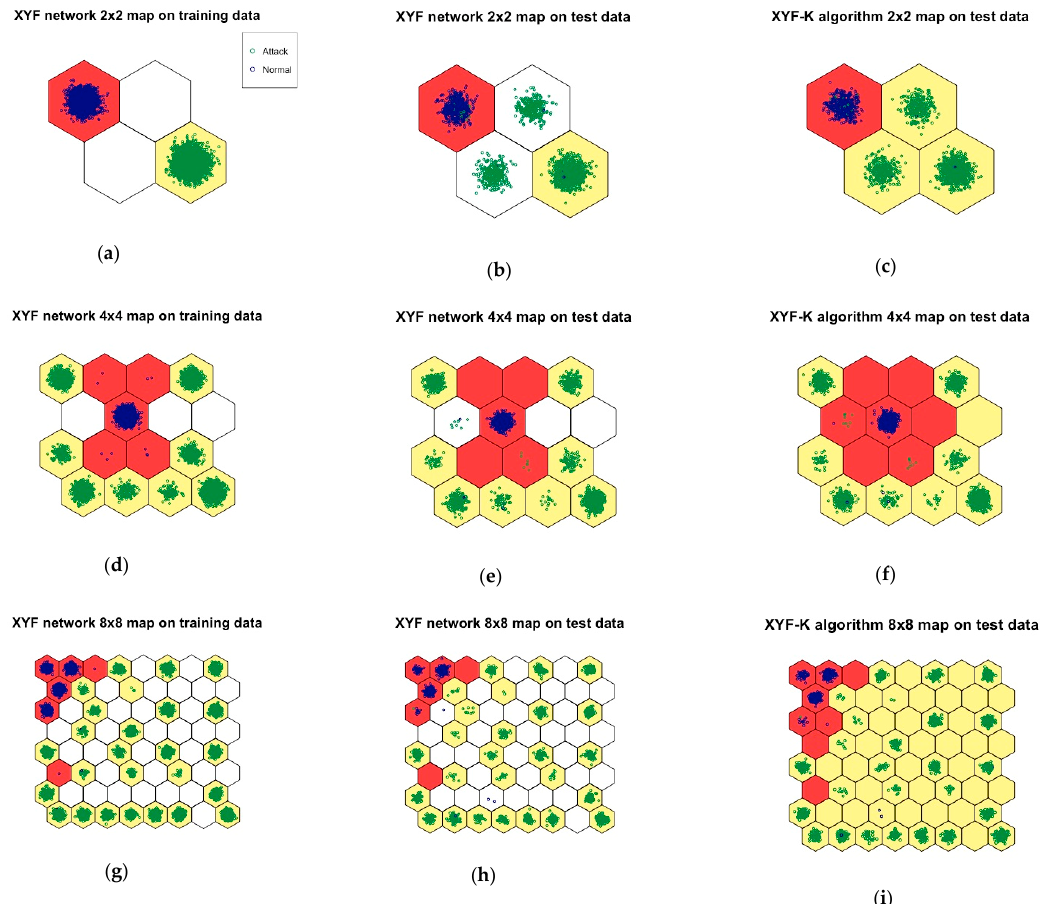
Figure 5. XYF network and XYF – K algorithm on the different neurons map sizes for the spoofing RPM dataset. ( a ) XYF network 2 × 2 map on training data; ( b ) XYF network 2 × 2 map on test data; ( c ) XYF-K algorithm 2 × 2 map on test data; ( d ) XYF network 4 × 4 map on training data; ( e ) XYF network 4 × 4 map on test data; ( f ) XYF-K algorithm 4 × 4 map on test data; ( g ) XYF network 8 × 8 map on training data; ( h ) XYF network 8 × 8 map on test data; ( i ) XYF-K algorithm 8 × 8 map on test data.